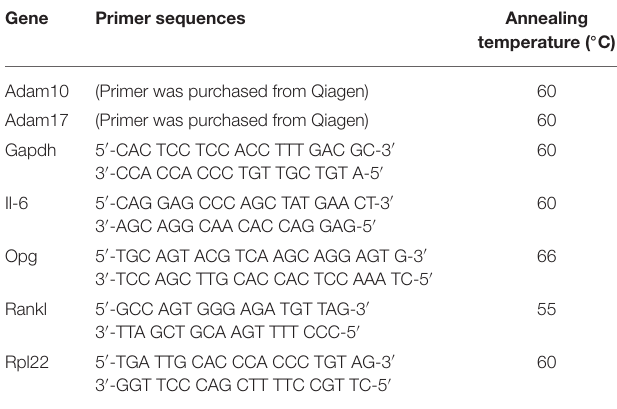
TABLE 1 | List of primers used for